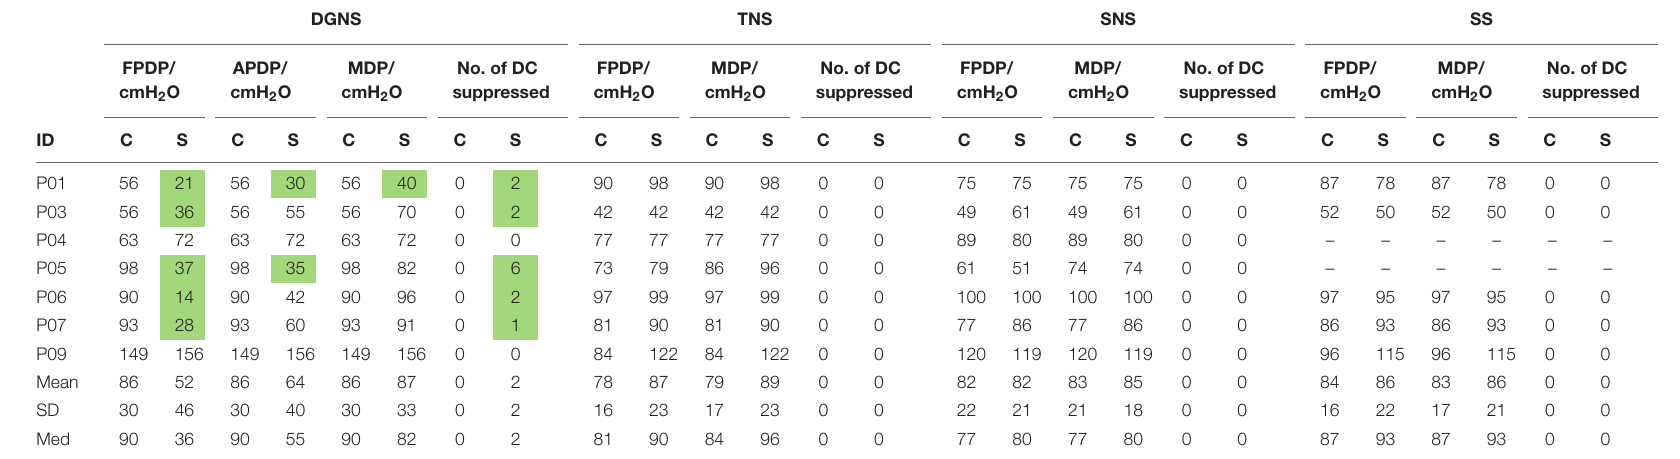
TABLE 4 | Detrusor pressure results from baseline and conditional stimulation